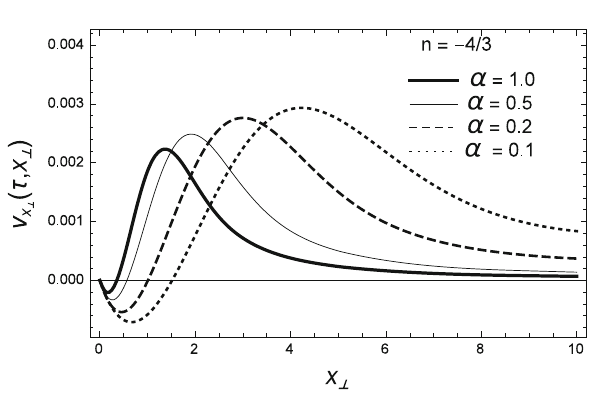
Fig. 19 b 2 φ (τ, x ⊥ ) as a function of x ⊥ for different values of α at τ 0 = 1 fm